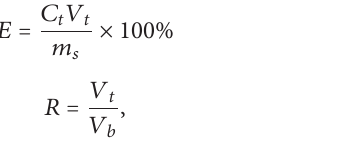
Figure 2, different volumes of [Bmim]BF